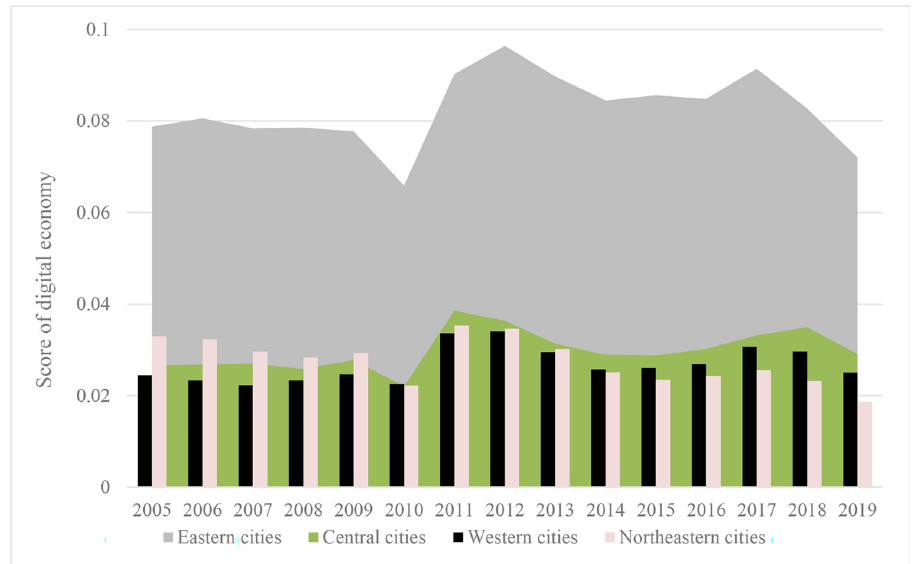
Fig 3. Digital economy development level at the different geographic